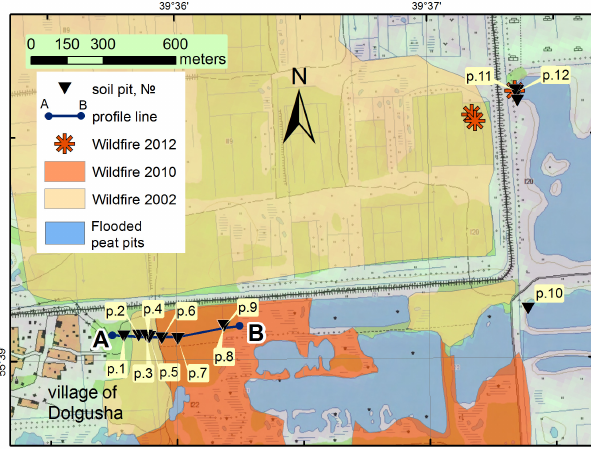
Figure 2. The location of the investigated soil pits.